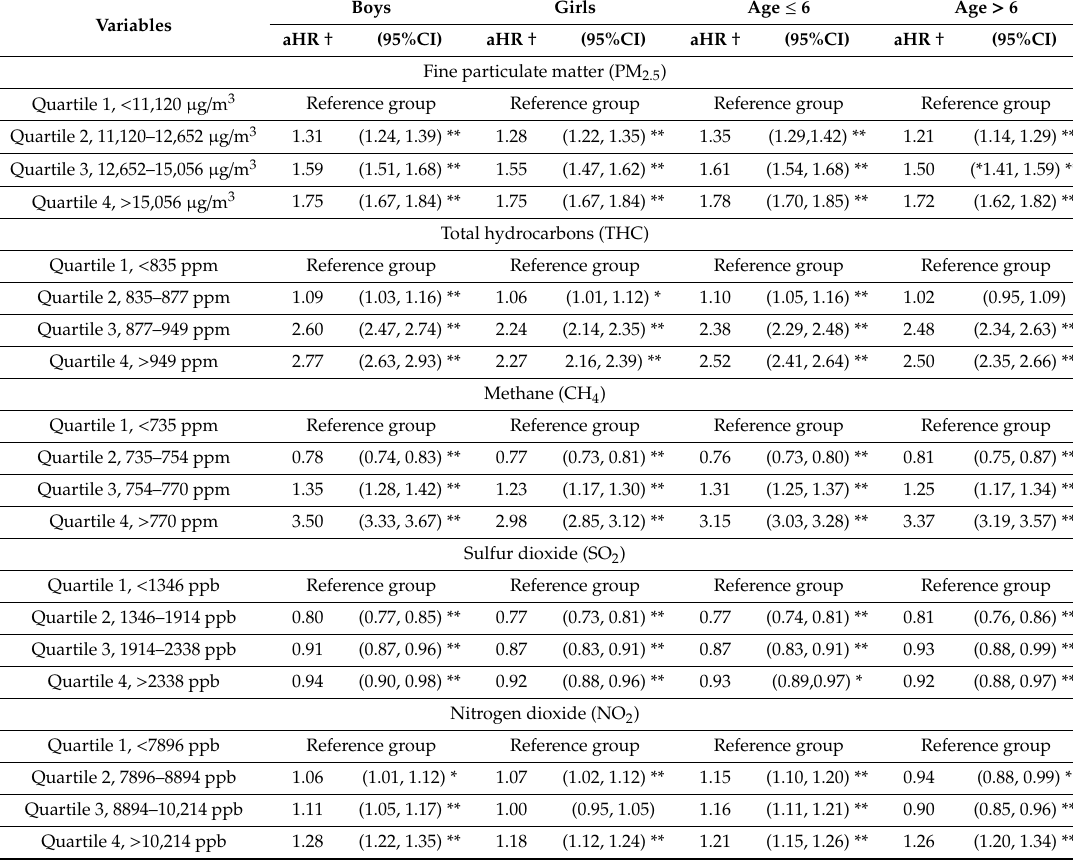
Table 3. The risk of recurrent headaches in children stratified by age, gender, and exposed to air pollutants stratified by quartile of annual average concentration in Cox proportional hazard